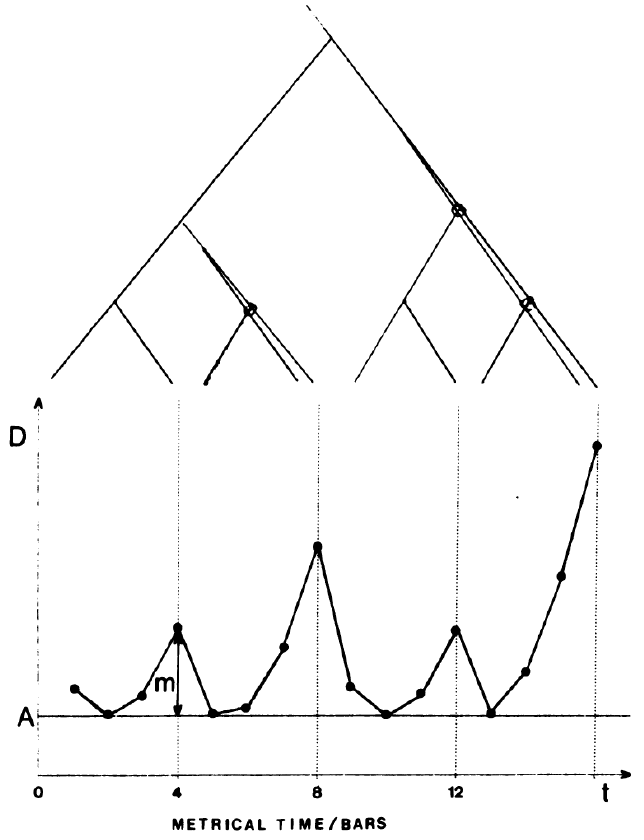
Figure 6. A tree diagram representing the hierarchical structure of the piece and, below, the cor- responding tempo variations generated by the model (the higher the value on the y-axis, the more pronounced the slowdown). Reprinted with permission from [39]. 1985, University of California